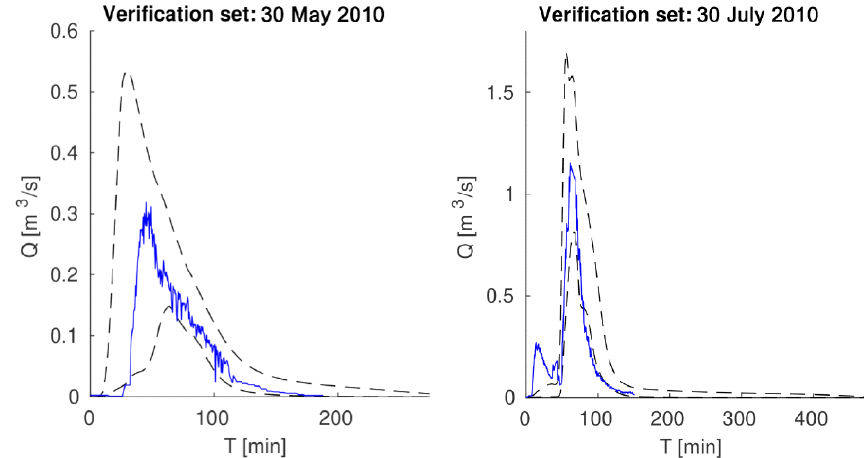
Hydrol. Earth Syst. Sci., 25, 5493–5516,